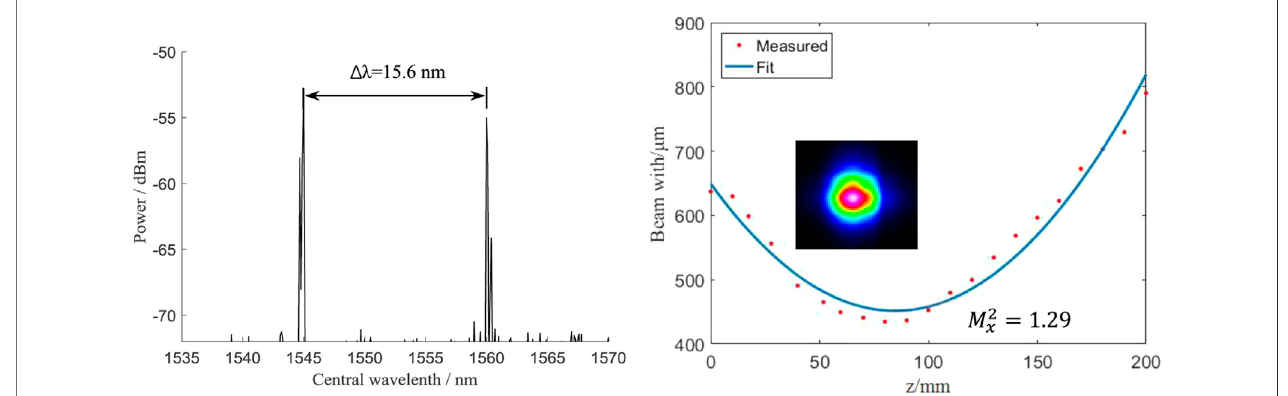
FIGURE 16 | The combined beam spectral and beam quality.